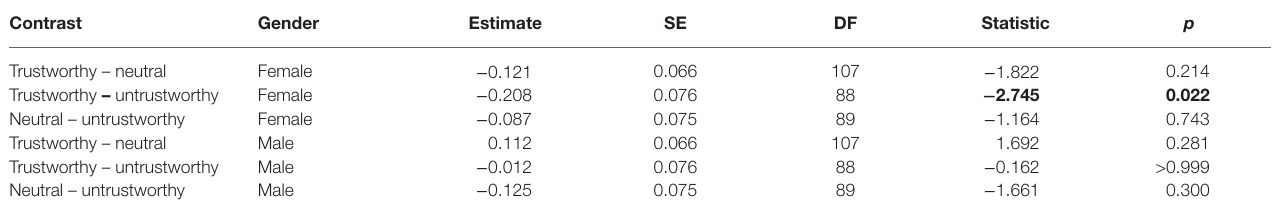
Significant results are in